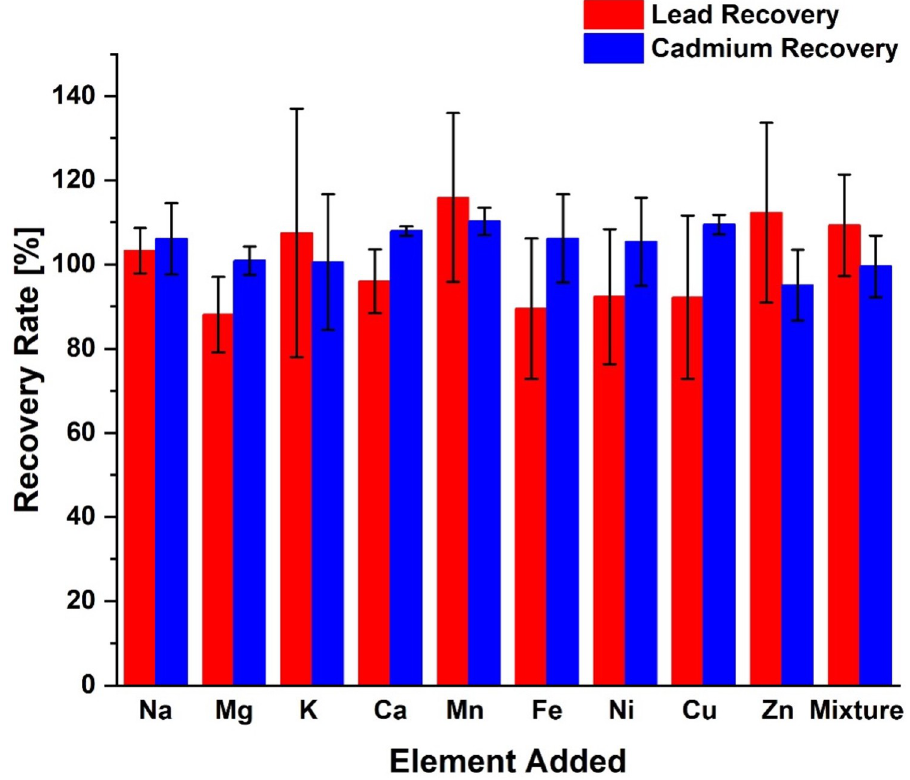
Fig 5. Average recovery rates for lead and cadmium in presence of potentially interfering elements. The concentration of those elements is shown in Table 1. Each element was investigated first individually and then a mixture of all elements